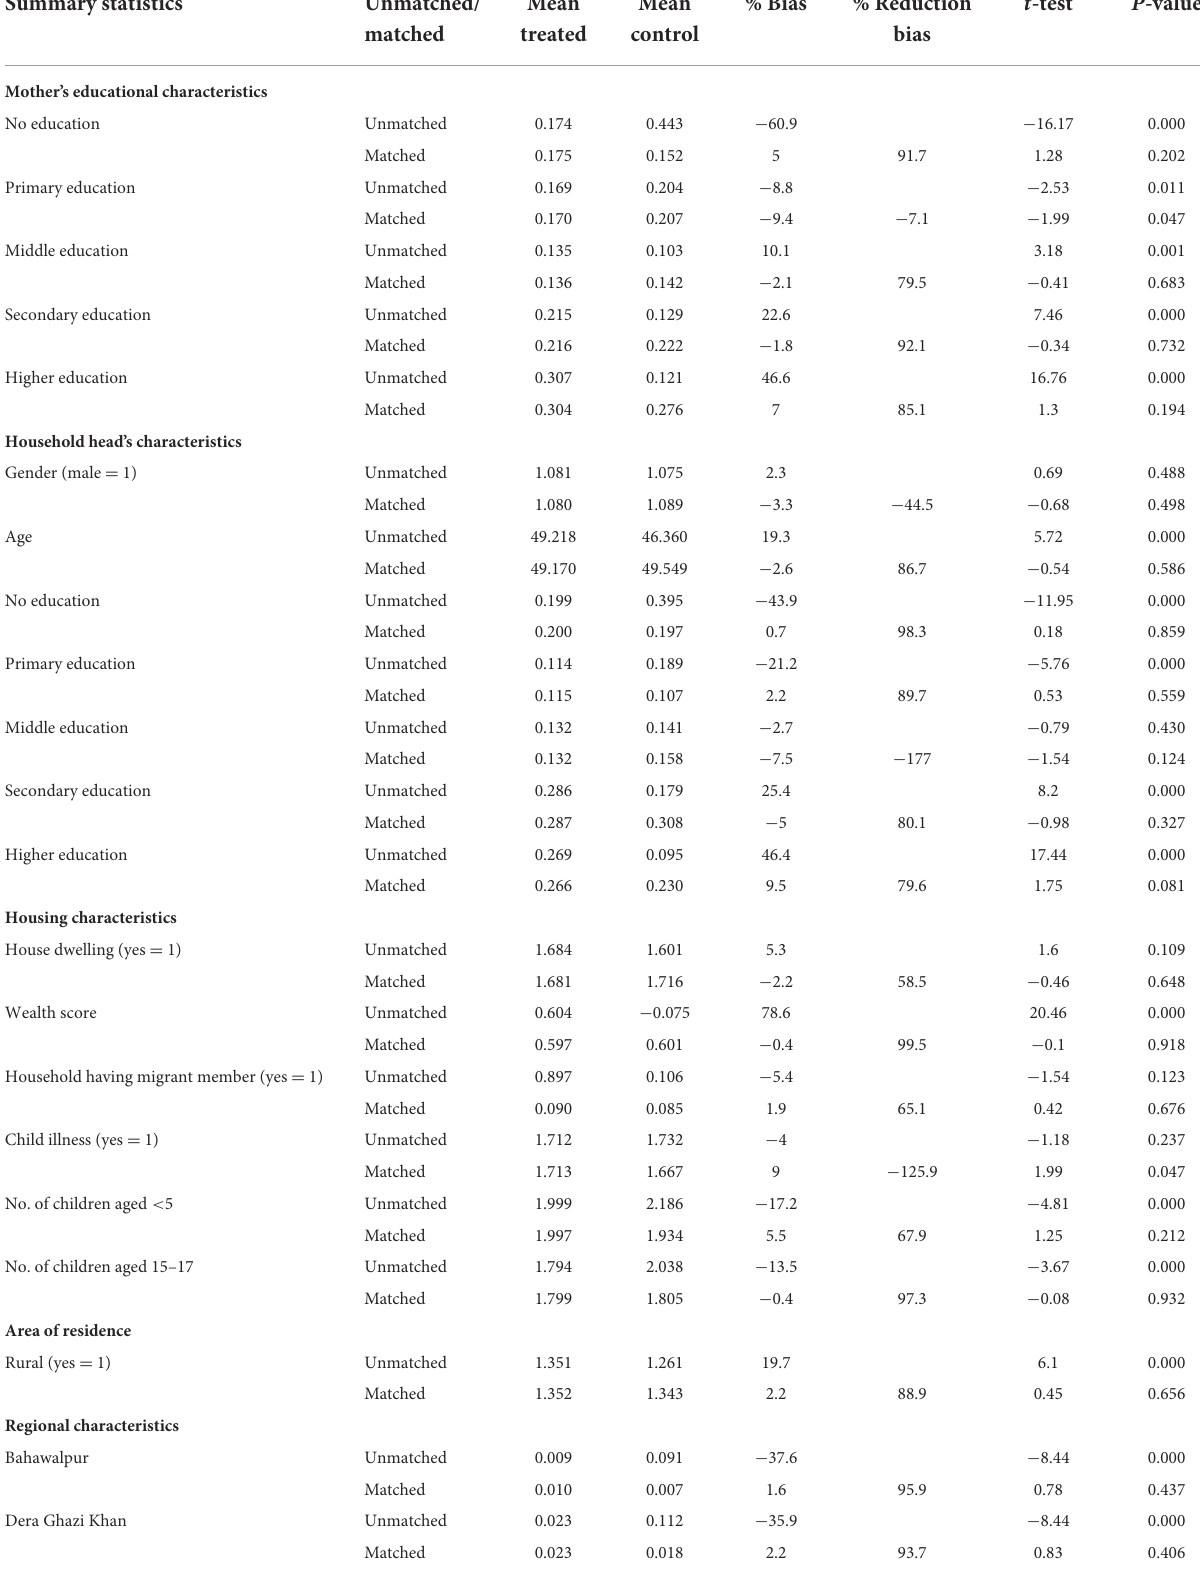
TABLE 4 Covariate balance between treated and control groups before and after